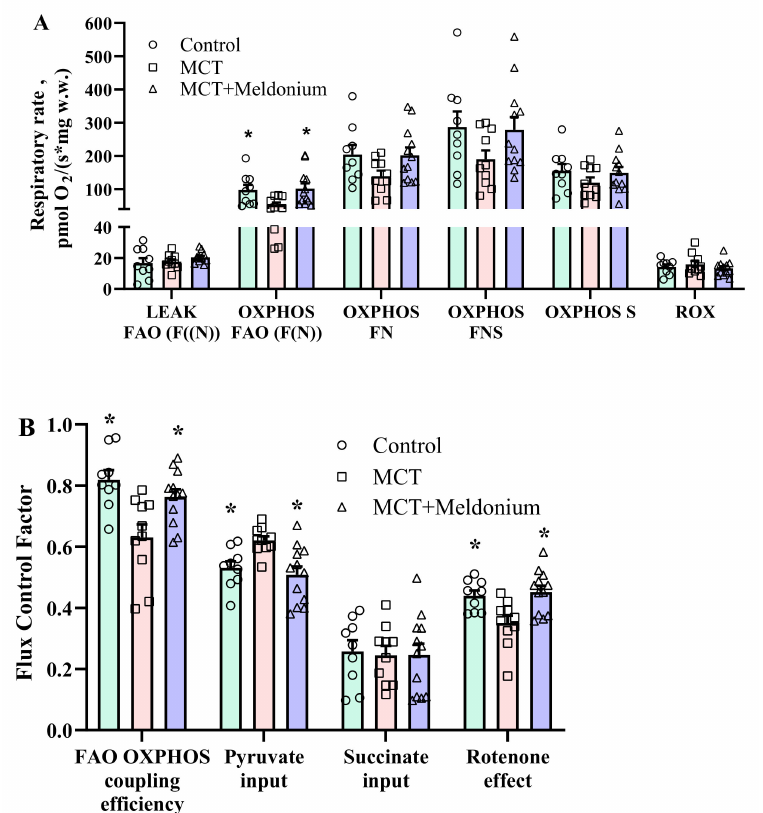
Figure 2. The effects of meldonium treatment (200 mg/kg for 4 weeks) on the mitochondrial res- piration rate ( A ) and flux control factors ( B ) in right ventricular (RV) cardiac fibers 4 weeks after monocrotaline (MCT) injection. MCT administration induced inhibition of fatty acid (FA)-dependent oxidative phosphorylation, stimulation of pyruvate metabolism and partial complex I dysfunction. Treatment with meldonium restored mitochondrial functionality in the heart. The results are pre- sented as the mean ± SEM of 9 to 12 animals. * p < 0.05 vs. the MCT group, one-way ANOVA with Dunnett’s multiple comparison test. Flux control factor, the contribution of each substrate/pathway to the respiration rate; S, succinate; F, FA oxidation-dependent pathway; N, NADH pathway; LEAK, substrate-dependent state; OXPHOS, oxidative phosphorylation-dependent state; ROX, residual oxygen